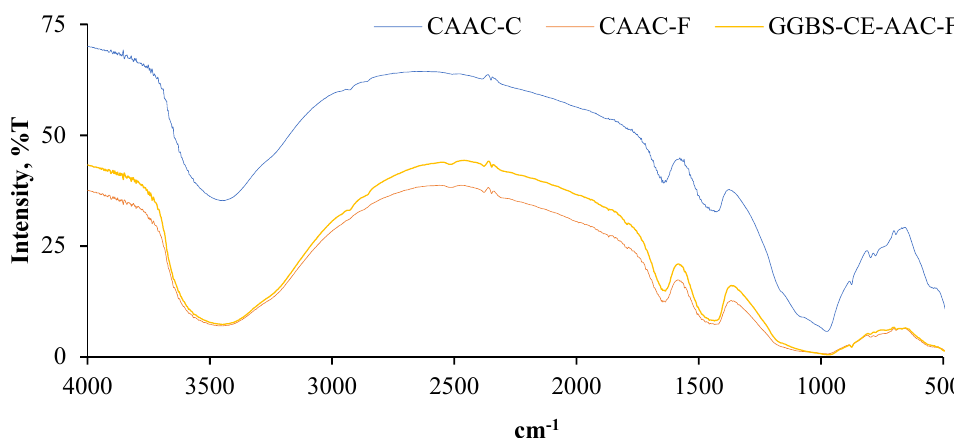
Figure 21. FTIR results of AAC specimens.